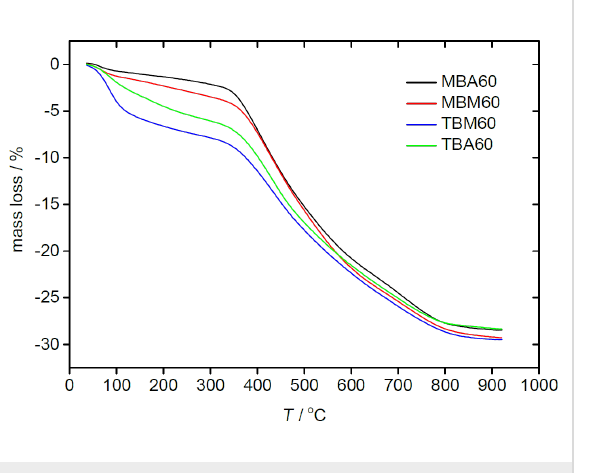
Figure 4: TGA data of pure organosilica monoliths.